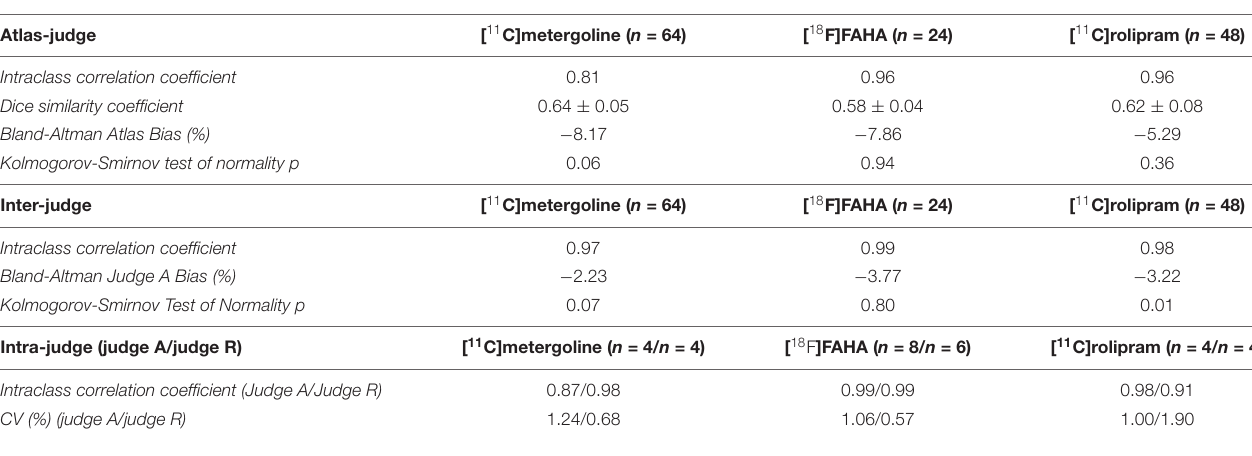
TABLE 5 | Summary of atlas evaluation on